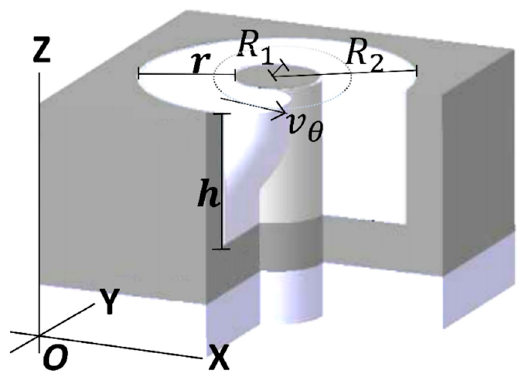
Figure 3. Annular channel cross-section and its main parameters: h (channel depth), r (channel width), R 1 (inner cylinder radius), R 2 (external cylinder radius), v θ (azimuthal